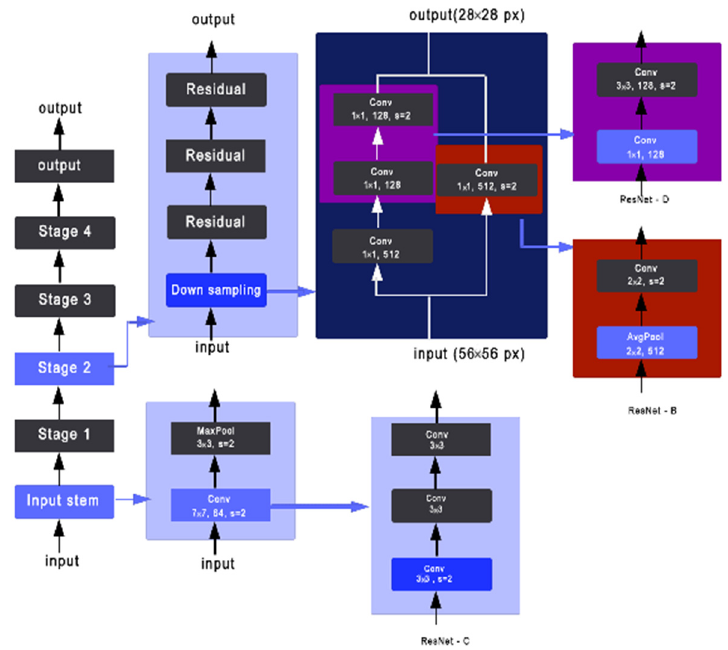
Figure 4. Key aspects of the xResNet50 architecture.